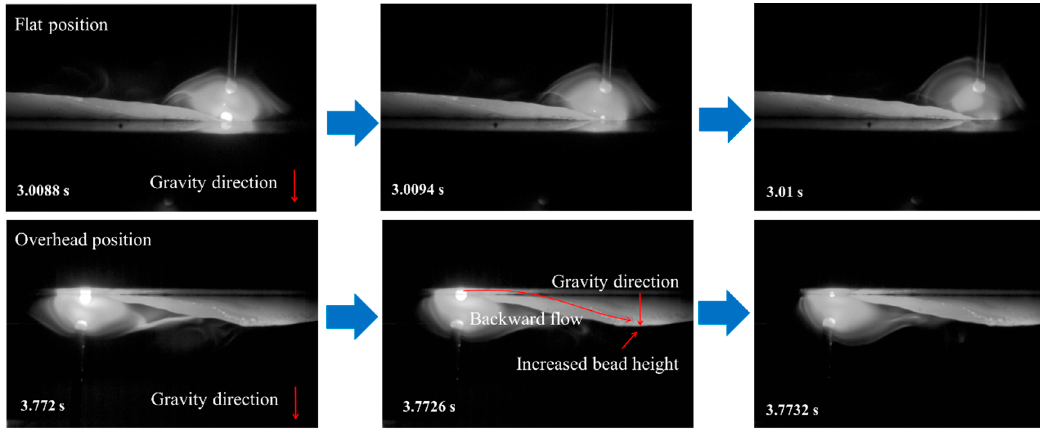
Figure 5. Characteristics of overhead welding position.